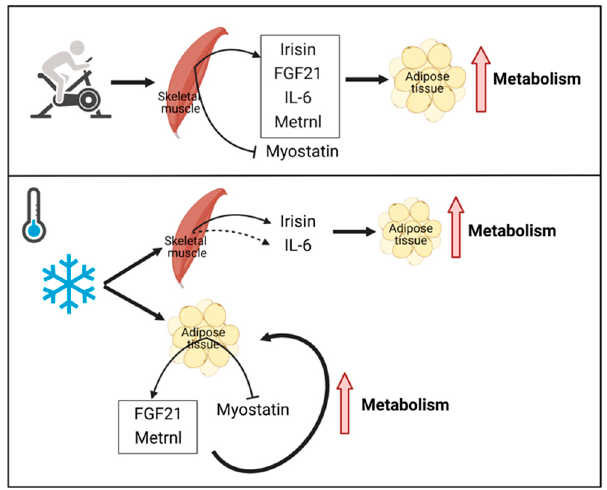
Figure 1. Myokines involved in adipose tissue metabolism with exercise and cold exposure. In humans, myokines (irisin, FGF21, IL-6, Metrnl and myostatin) secreted by skeletal muscle in response to exercise play important roles in adipose tissue metabolism. On the other hand, cold exposure can induce the expression of irisin in skeletal muscle, FGF21 and Metrnl in adipose tissue, and inhibit the expression of myostatin in adipose tissue, thus increasing energy metabolism. Abbreviations: FGF21: fibroblast growth factor 21; IL-6: interleukin 6; Metrnl: Meteorin-like.